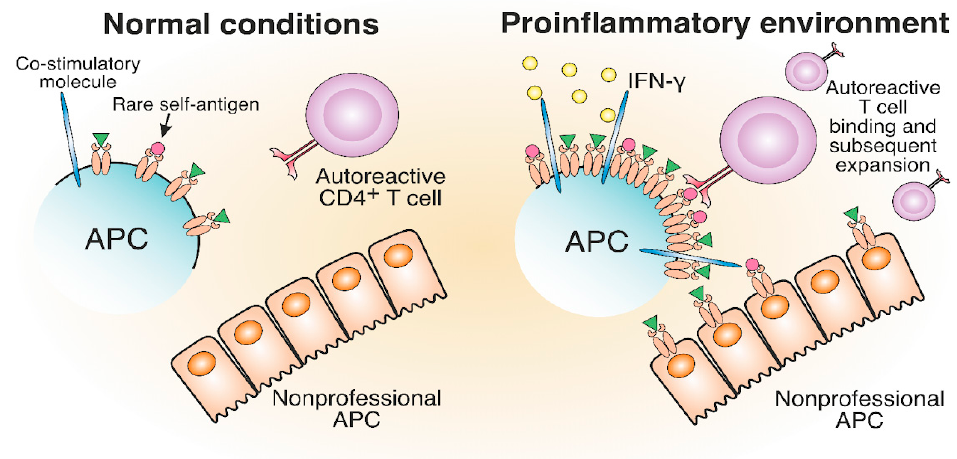
Figure 5. The development of autoreactive CD4 + T cells in a proinflammatory environment. The proinflammatory environment caused by viral or bacterial infection entails IFN- γ production, which results in increased MHC-II and costimulatory molecule expression compared to normal conditions. Therefore, rare self-antigens are present in a greater number, which can lead to the potential activation of autoreactive T cells.